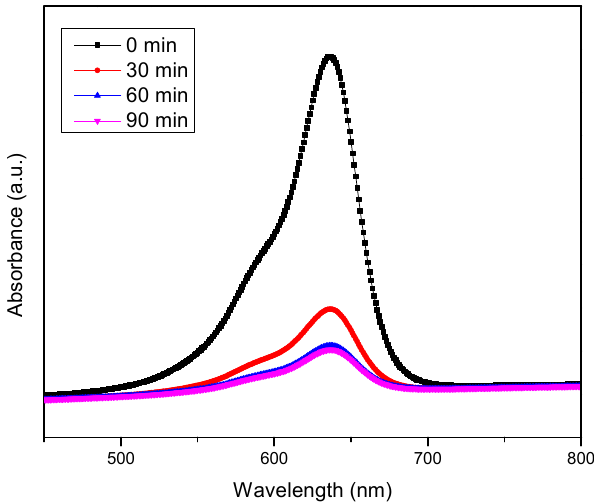
Figure 10. UV-Vis spectra of MB dye degradation using RF/TiO 2 gel.